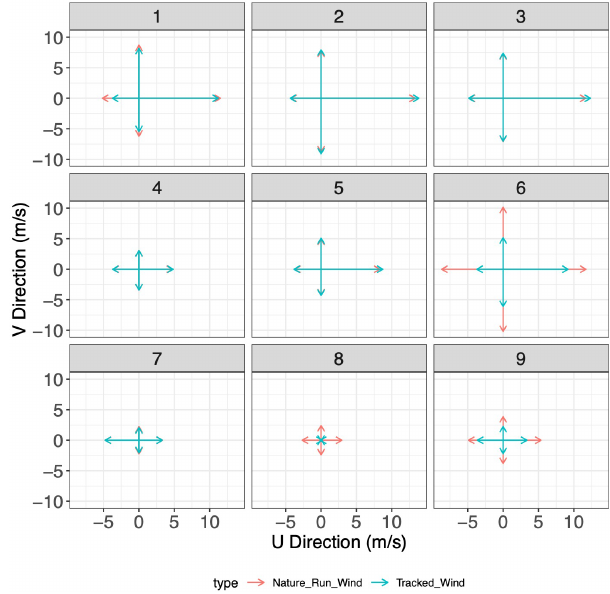
Figure 9. Mean tracked winds and Nature Run winds, in each di- rection, for each cluster applied to the test set. Each sub-panel rep- resents the cluster each point was assigned to.